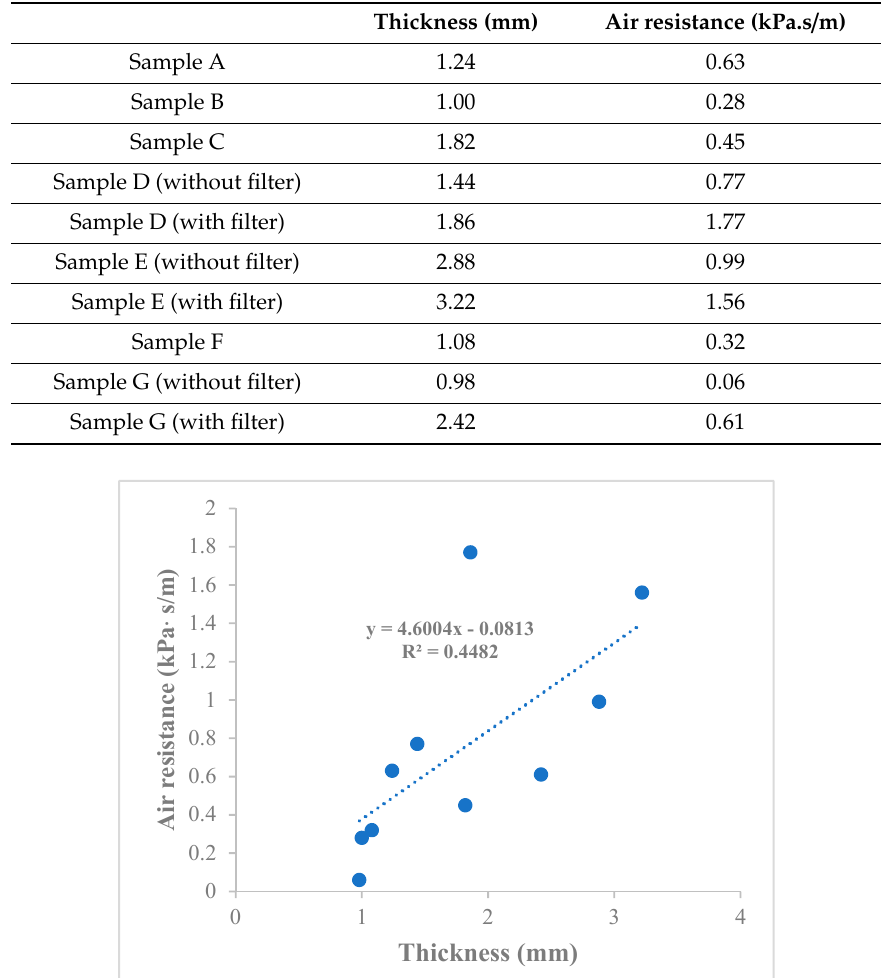
Table 2. Thickness and air permeability of masks.